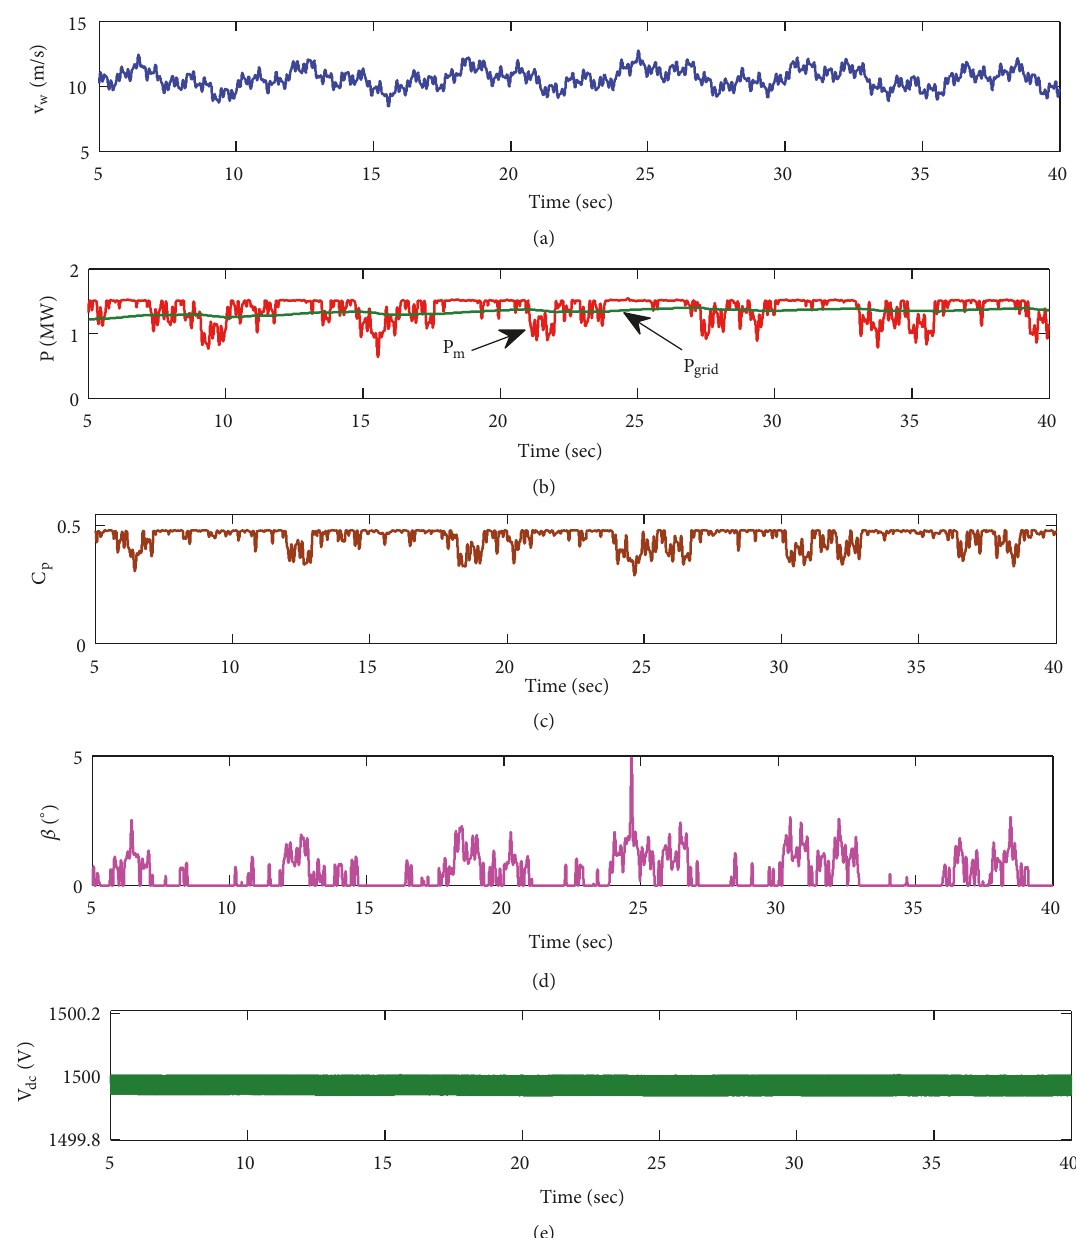
Figure 15: (a) wind speed profile, (b) wind turbine power ( P (d) pitch angle, and (e) DC-link voltage, in